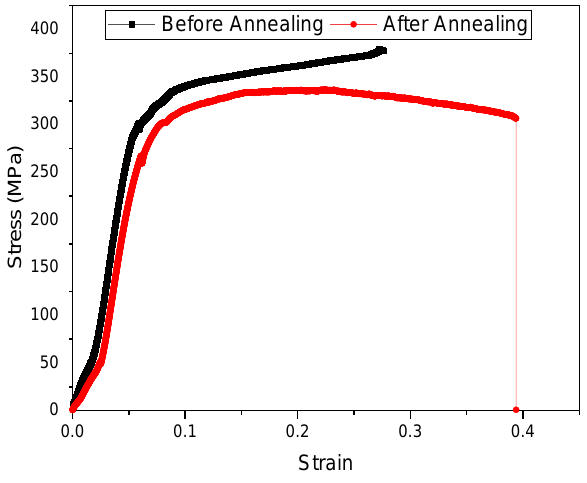
Fig. 7. SCC of cold rolled & 50°C